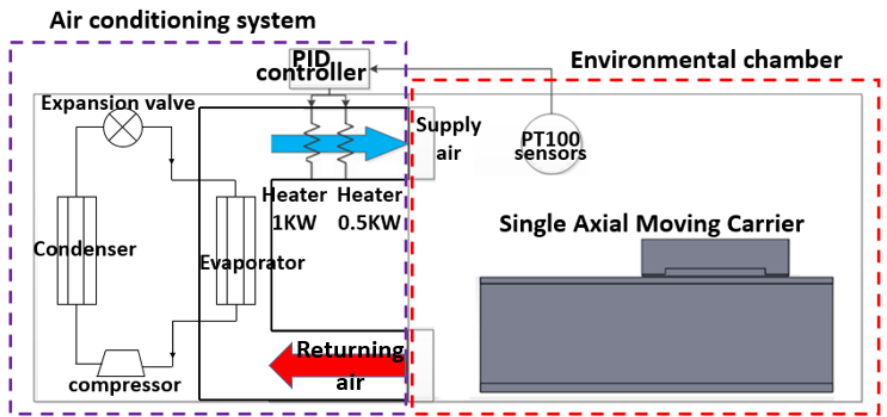
Figure 3. Schematic diagram of environmental control system in the study.